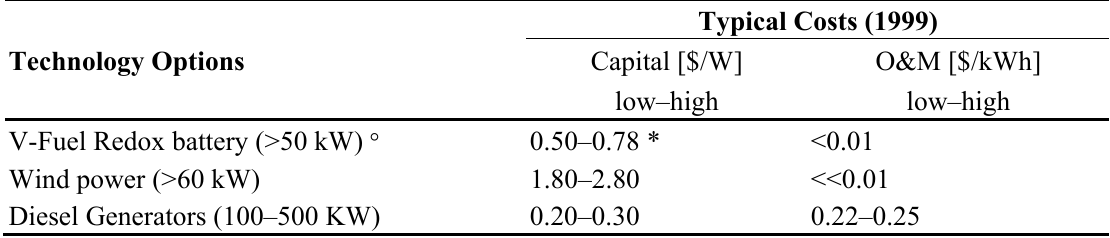
Table 1. Cost data for renewable technology options (1999) [14].